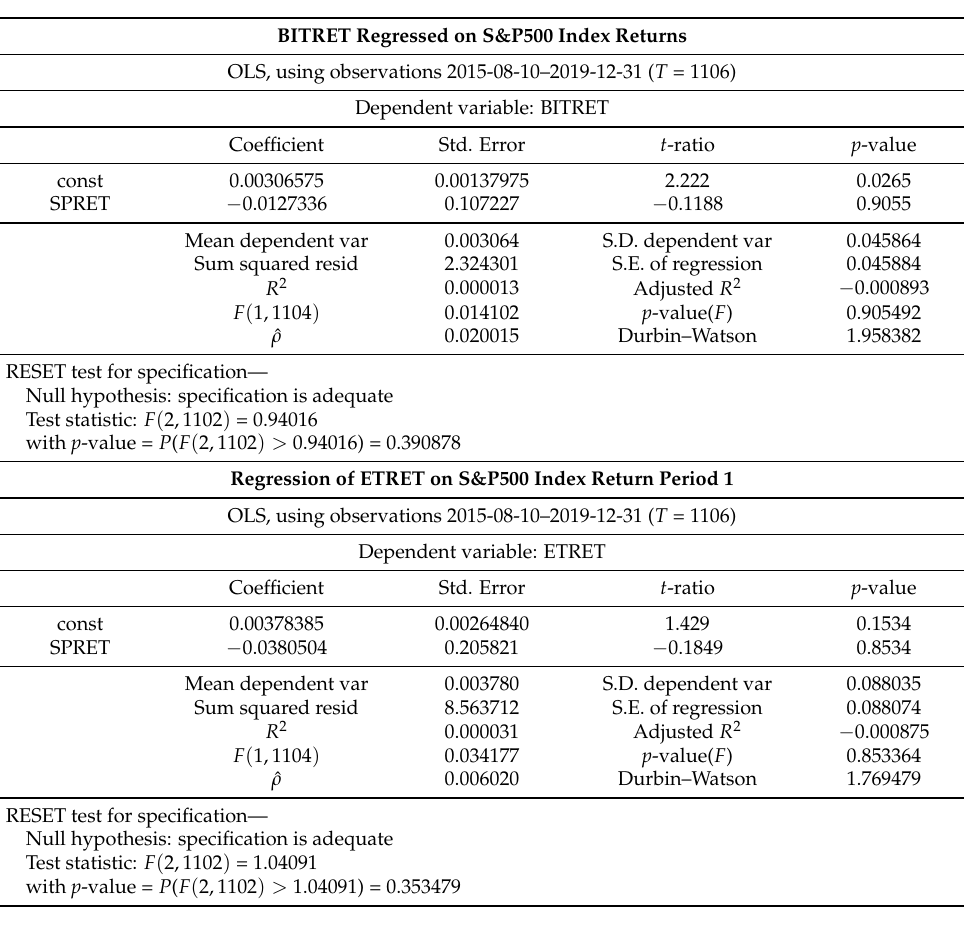
Table 4. Cryptocurrency returns regressed on S&P500 Index returns Period 1.